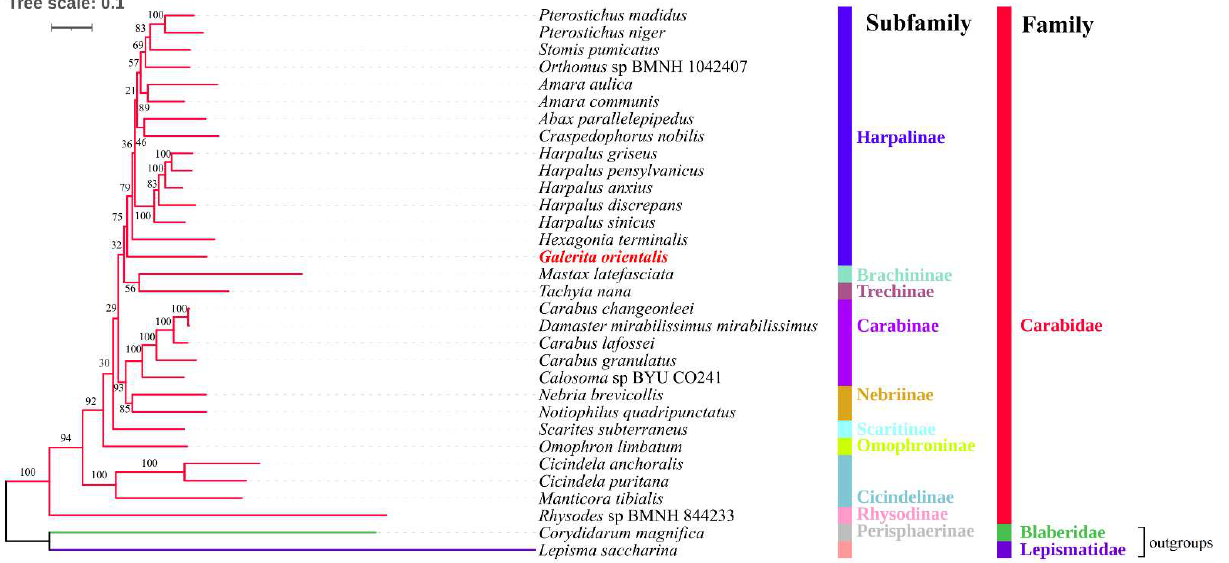
Figure 7. Maximum likelihood phylogenetic tree of nucleotide sequences of 13 protein-coding genes (PCGs) of 32 mitogenomes using IQ tree under the GTR + F + I + G4 model. Maximum likelihood (ML) bootstrap support values are indicated near the nodes. The newly determined Galerita orientalis is shown in red. The branches of the family Carabidae are shown in red. L . saccharina and Co . magnifica are outgroups, and the corresponding branches are shown in green or purple.